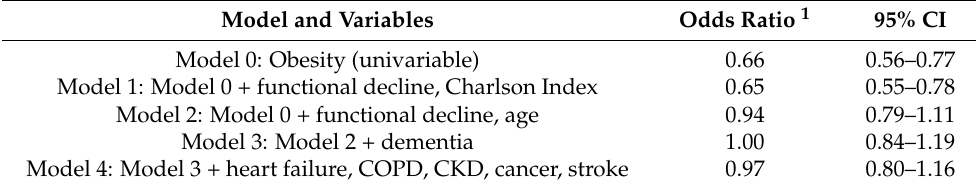
Table 5. Multivariable ordinal logistic regression of goals of care on obesity status ( n = 4599).